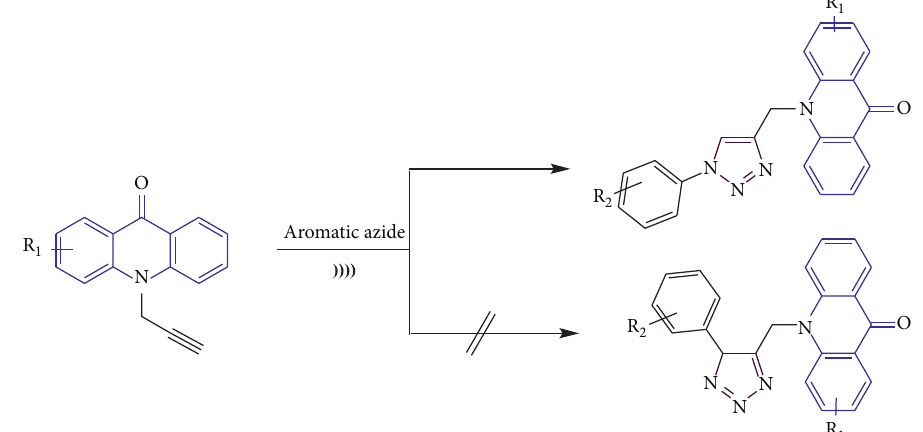
Figure 6: Synthesis of 1,4-disubstituted